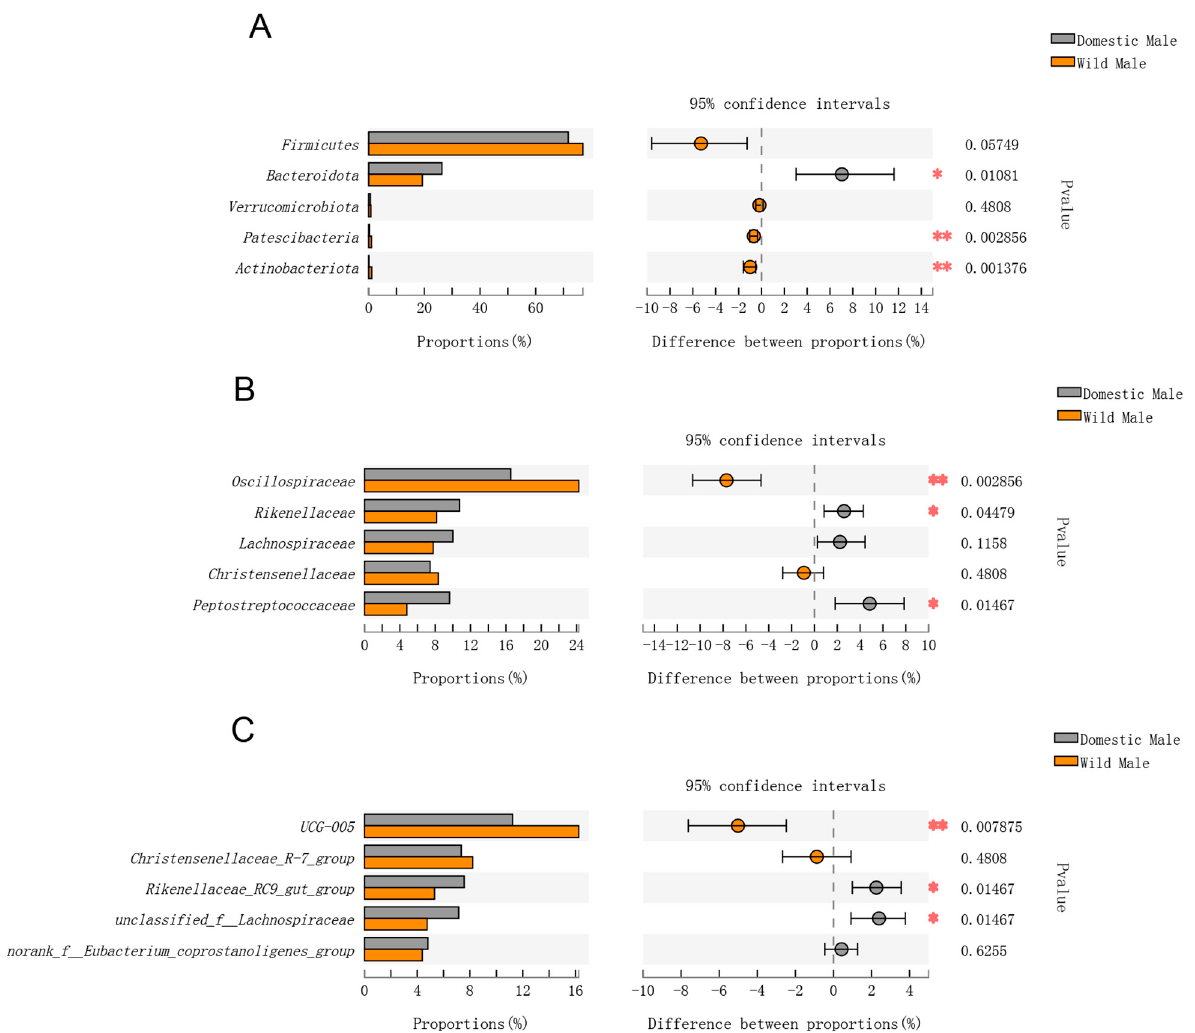
Figure 3. Comparison of gut microbial diversity between domestic Datong males and wild male yaks. ( A ) Top five phyla; ( B ) top five families; ( C ) top five genera. Significant differences in the gut microbiota between domestic Datong females and wild male yaks are indicated by p values and asterisks (* if 0.01 < p < 0.05, ** if 0.001 < p < 0.01).